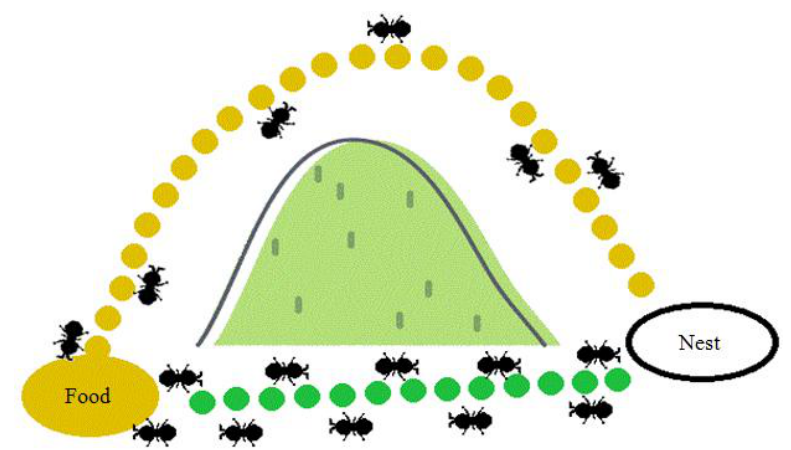
Figure 2. Ants take shorter path after initial search